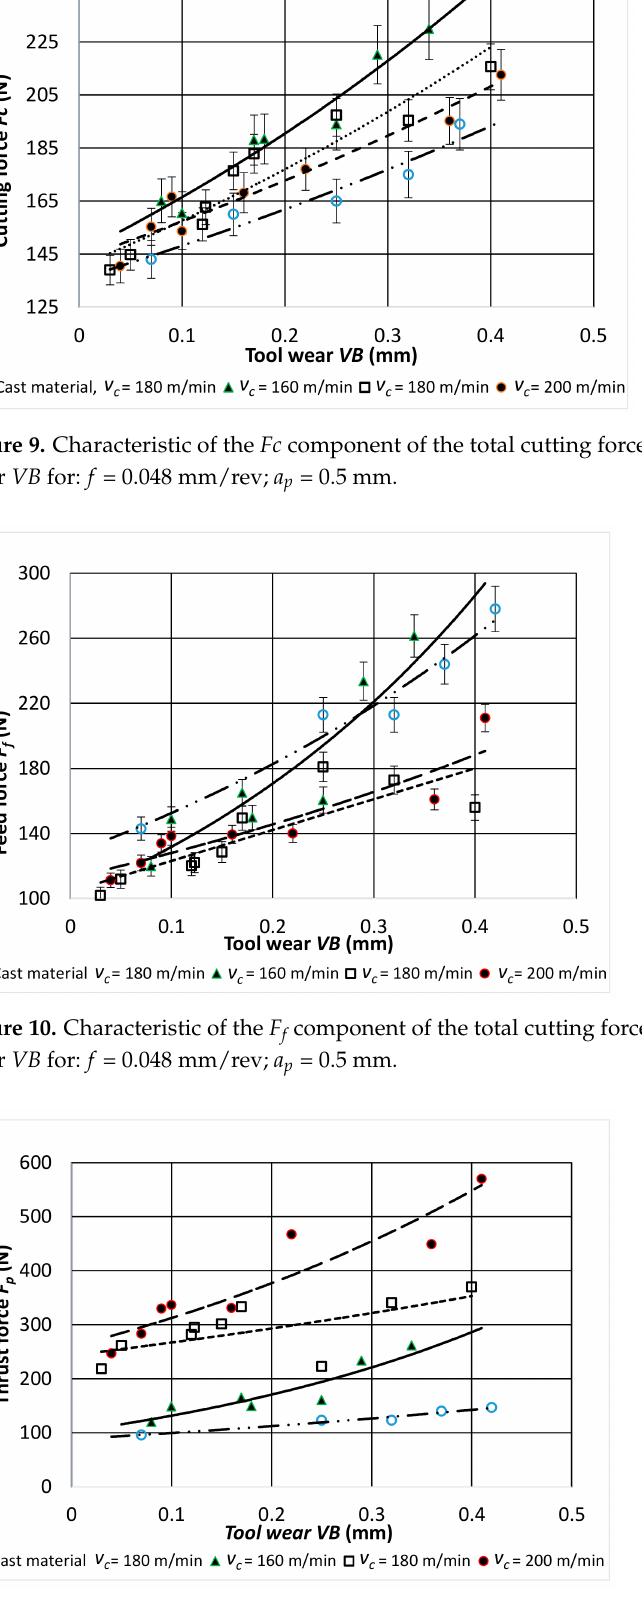
Figure 11. Characteristic of the F p component of the total cutting force as a function of cutting edge wear VB for: f = 0.048 mm/rev; a p = 0.5